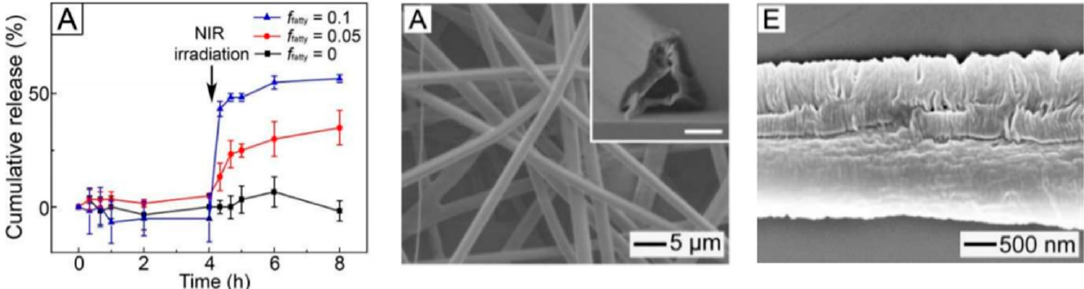
Figure 15. ( left side ) Cumulative release of DOX-gold-nanocages-membrane for various fatty acids values; ( middle ) SEM of the membrane with 0.05 fatty acids before NIR radiation; ( right side ) SEM of the membrane with 0.05 fatty acids after NIR radiation. Reprinted from “Gold nanocage-incorporated poly( ε -caprolactone) (PCL) fibers for chemophotothermal synergistic cancer therapy.” Pharmaceutics 2019, 11, 60, Figures 6 and 7 [179].